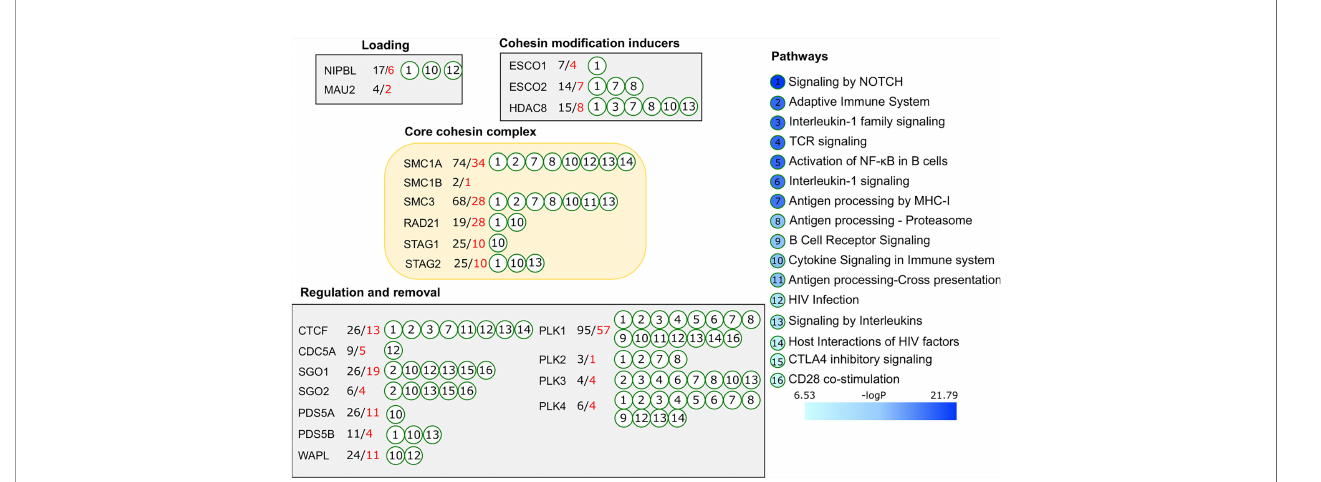
FIGURE 3 | Functional enrichment analysis of the cohesin complex proteins. Experimentally con fi rmed protein-protein interactions for 22 proteins of the cohesin complex were retrieved from the BioGrid database. Functional enrichment analysis was done in Reactome. Immunologically relevant pathways (FDR p-value <10 -5 ) are presented on the right side and annotated to individual cohesin complex proteins by circled numbers corresponding to the immunologically relevant pathways. Number of interactors is shown next to each protein. Total number of interactors is indicated in black, immunologically relevant interactors are shown in red